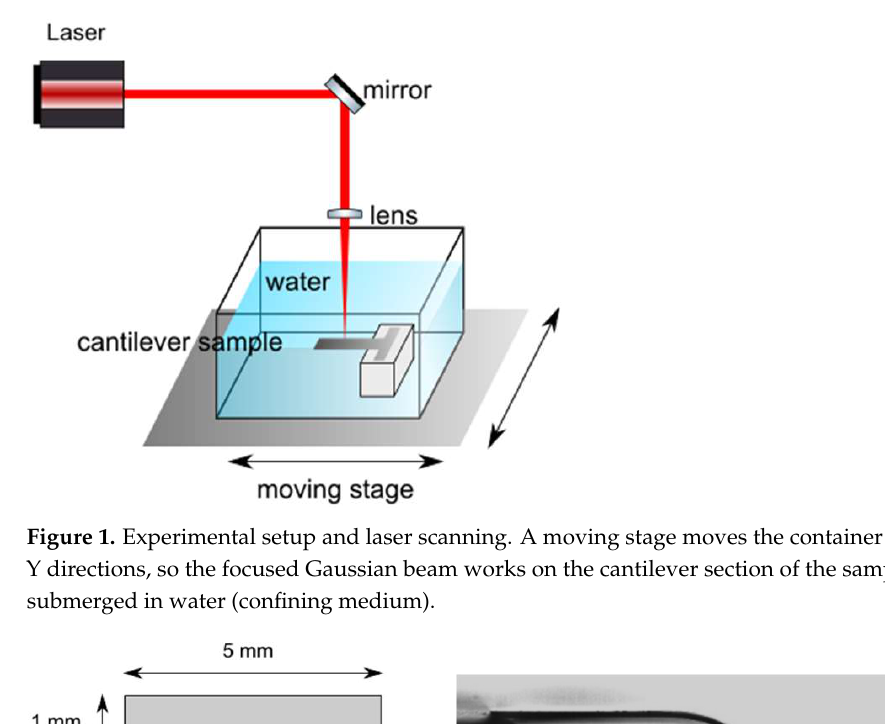
( b ) Figure 2. ( a ) The laser begins working at the furthest position of the cantilever section outside the sample. The stage moves as the axes are displayed; in this way, the working area is always in focus. The picture also shows P (cid:2934) and P (cid:2935) . ( b ) A 316 steel sample after the process.